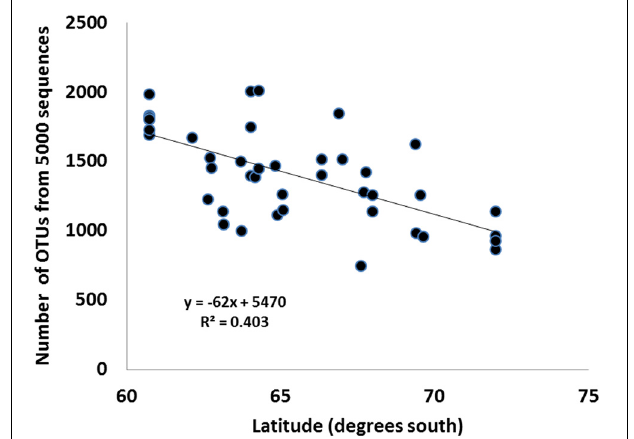
FIGURE 9 | Moss and algal communities associated with resources from whale bones (Livingston Island).